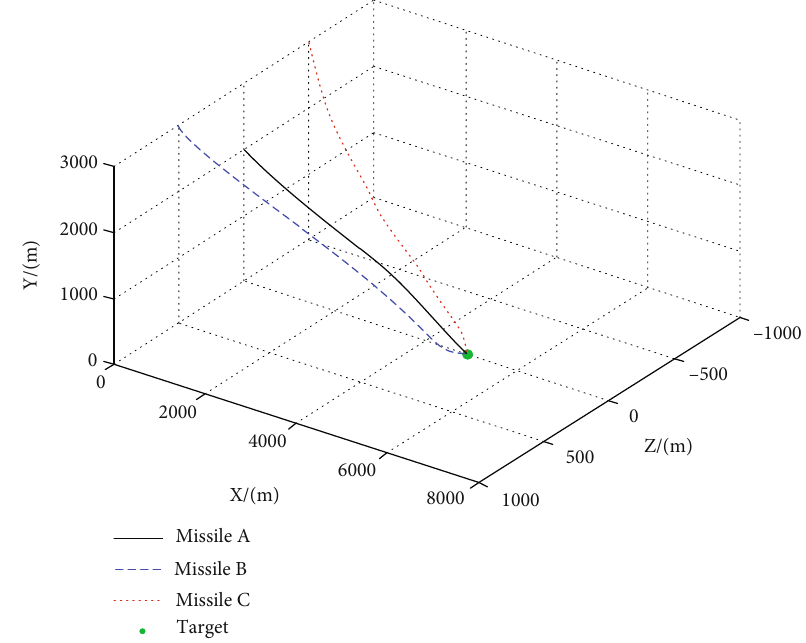
Figure 5: Three-dimensional trajectory of missiles A, B, and C and the target in angle penetration attack.